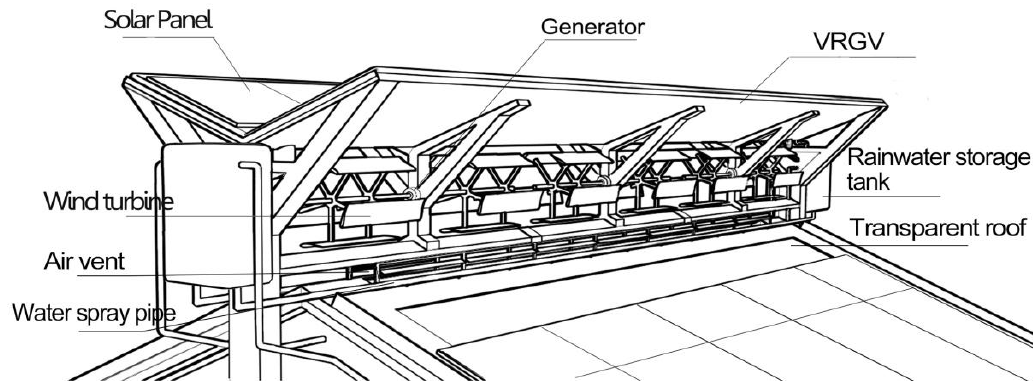
Figure 6. Structural features of the eco-roof system with VRGV.